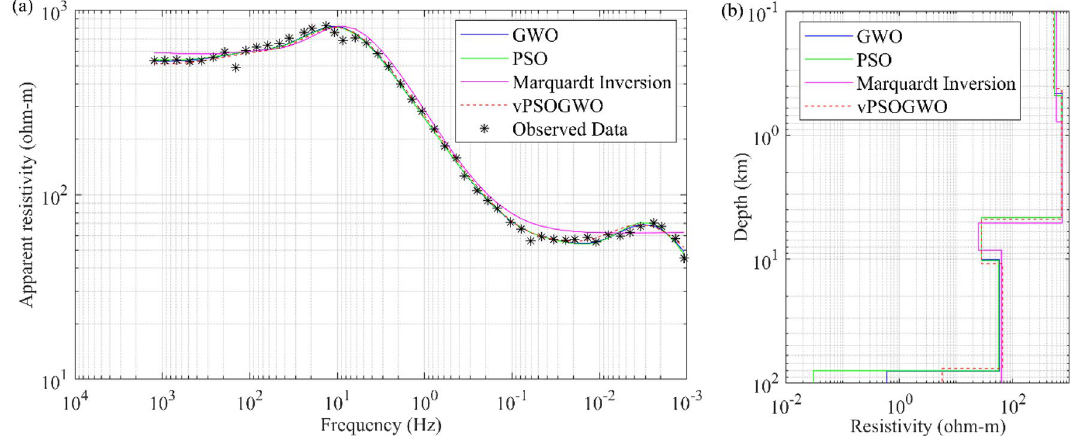
Figure 16. Five-layers MT field data over Western Puga valley geothermal field, Ladakh, India: ( a ) observed (*) and the best-fitted apparent resistivity curves using GWO, PSO, Marquardt 44 , and vPSOGWO; ( b ) 1-D mean model (bpdf > 68.27% CI) inverted by vPSOGWO (red), Marquardt (magenta), PSO (green) and GWO